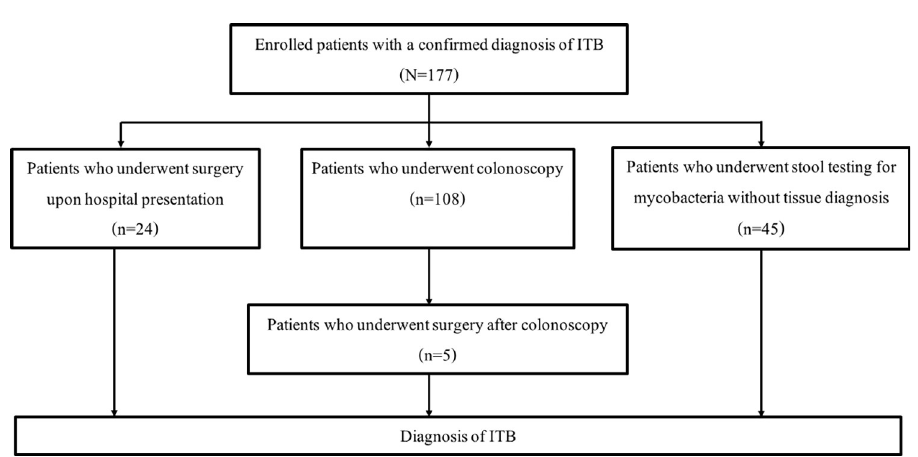
Fig 2. Diagnostic methods of intestinal tuberculosis of patients.